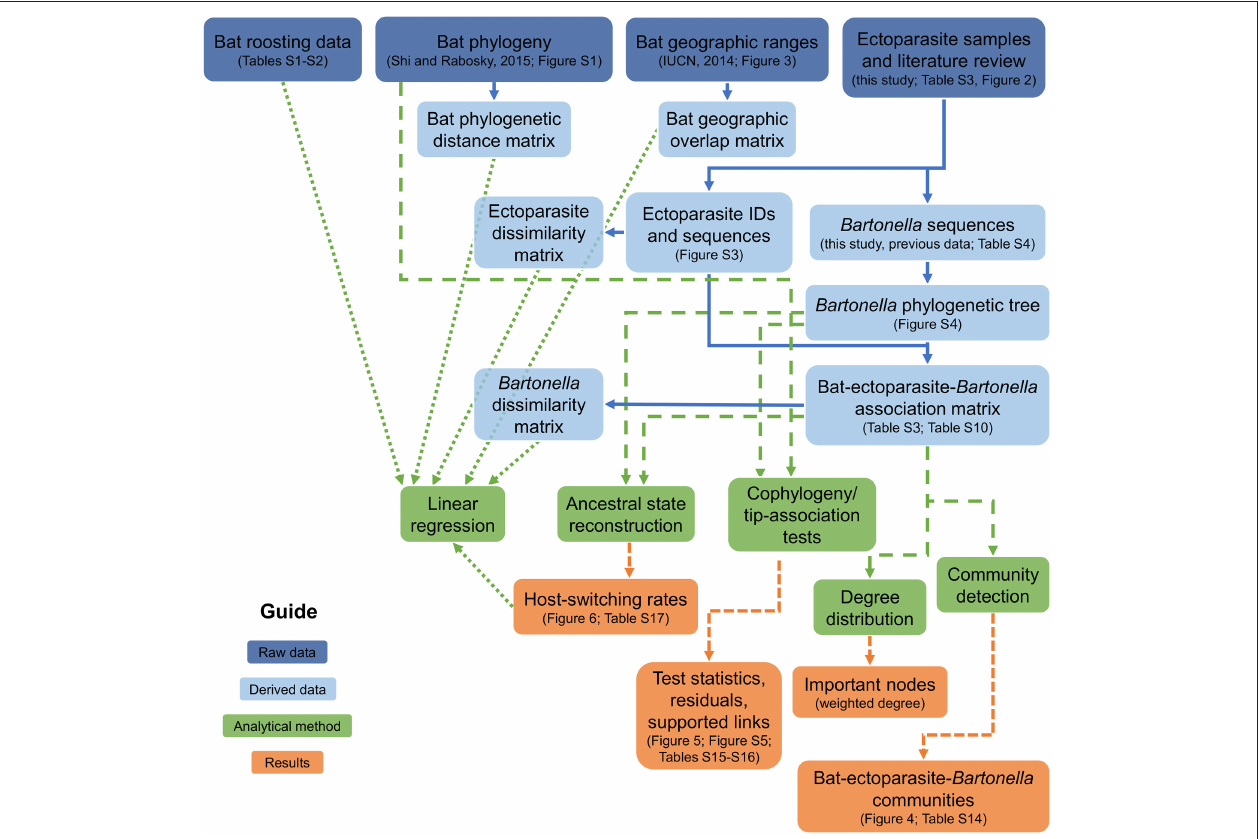
FIGURE 1 | Analysis framework diagram. Boxes link raw data (dark blue) to derived data (light blue), analytical methods (green), and results (orange) to connect all of the scientific analyses used in the